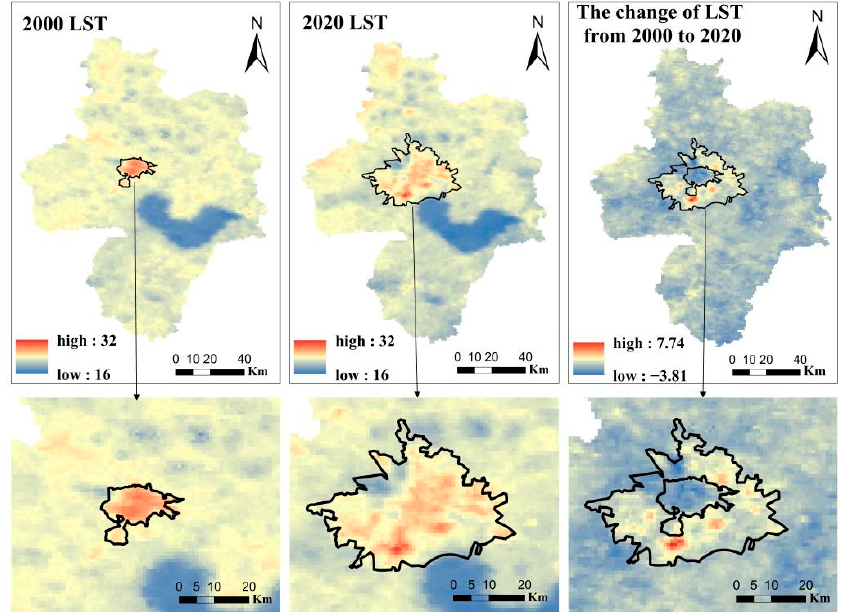
Figure 9. Comparison of the annual mean LST in Hefei from 2000 to 2020.